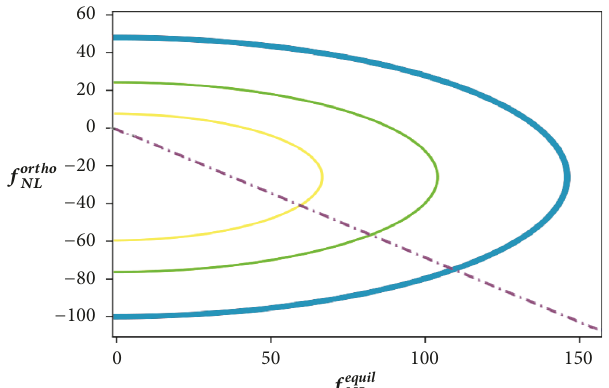
Figure 2: The amplitude of the orthogonal configuration versus the amplitude of the equilateral configuration of non-Gaussianity in the background of Planck2015 TTT, EEE, TTE, and EET